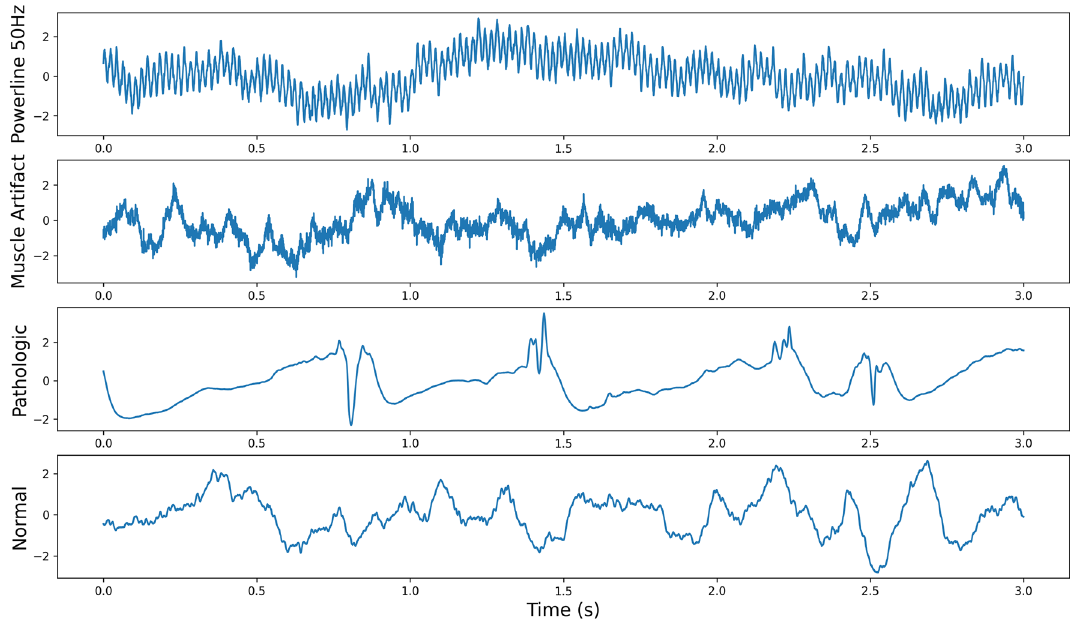
Figure 1. Example of iEEG segments from each classification group in the dataset.